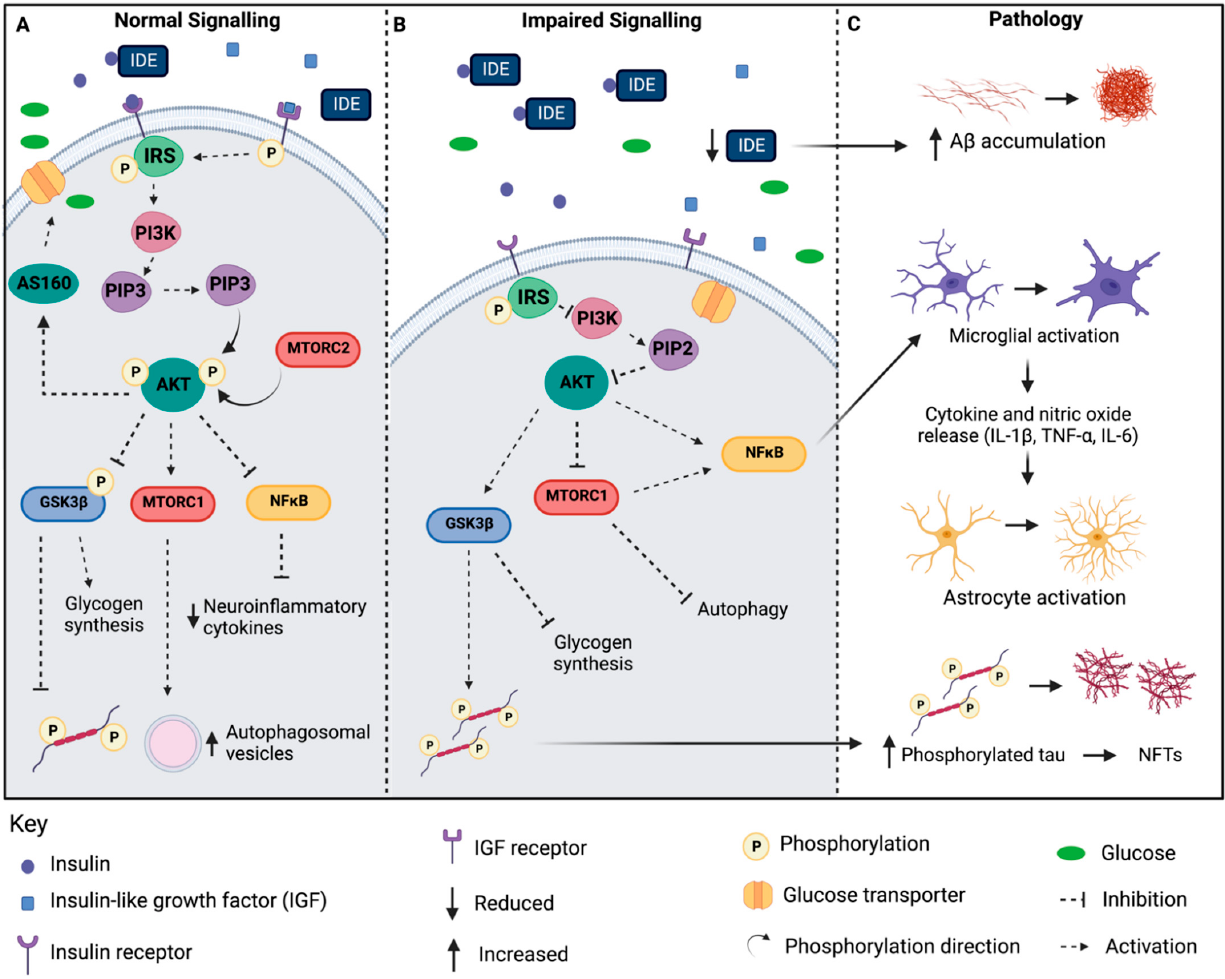
Figure 1. Impaired insulin signalling in Alzheimer’s disease. ( A ) Normal insulin signalling pathway. ( B ) Impaired insulin signalling in the brain. ( C ) Pathological outcomes of impaired insulin signalling in Alzheimer’s disease. Abbreviations: IRS represents insulin receptor substrate. IDE represents insulin-degrading enzyme. PI3K represents phosphoinositide-3-kinase. PIP-2 represents phosphatidylinositol biphosphate. PIP-3 represents phosphatidylinositol 3,4,5 triphosphate. AKT represents protein kinase B. GSK3 β represents glycogen synthase kinase 3 β . MTORC1 represents mammalian target of rapamycin complex 1. MTORC2 represents mammalian target of rapamycin complex 2. NF κ B represents nuclear factor κ light chain enhancer of activated B Cells. IL represents interleukin. TNF represents tumour necrosis factor. NFT represents neurofibrillary tangles. A β represents amyloid- β . Created with BioRender.com.